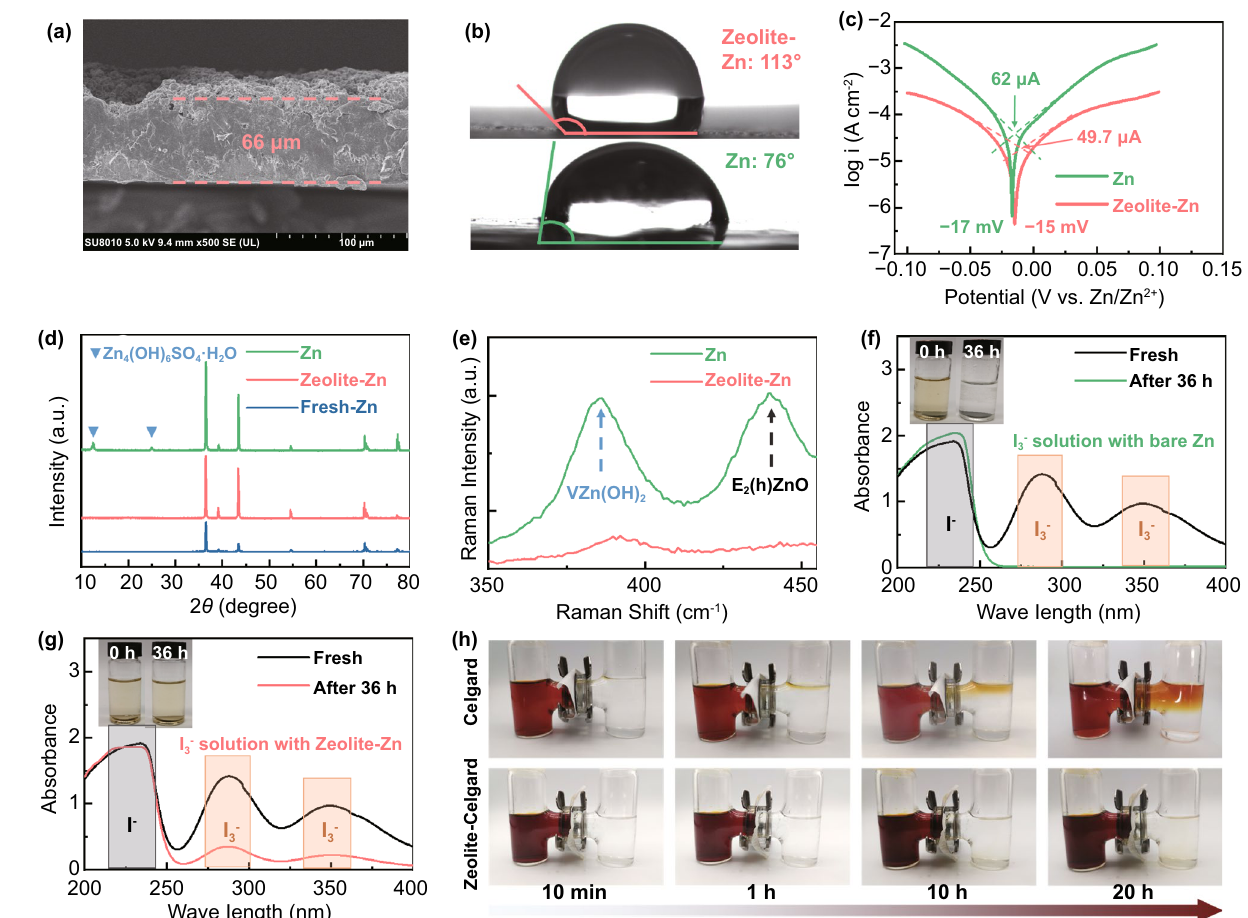
Fig. 1 a A typical cross-sectional SEM image of the zeolite protecting layer. b Contact angles of 1 M ZnSO 4 electrolyte on either a bare- or Zeolite-Zn foil. c Tafel curves of a bare- and Zeolite-Zn foil in the electrolyte. d XRD patterns and e Raman spectra of the bare- and Zeolite- Zn foil after 15 days static corrosion in 1 M ZnSO 4 electrolyte. f‑g UV–vis absorption spectra of the I 3− electrolytes before and after soaking a bare- or Zeolite-Zn disc for 36 h. h Photographs showing the I 3− -shuttling rate across a bare and zeolite-coated commercial Celgard separator. The right and left tanks of the H-shape container were filled with deep brown triiodide solution (i.e., 0.1 M KI + 0.1 M I 2 , left tank) and colorless 0.1 M KI solution (right tank),